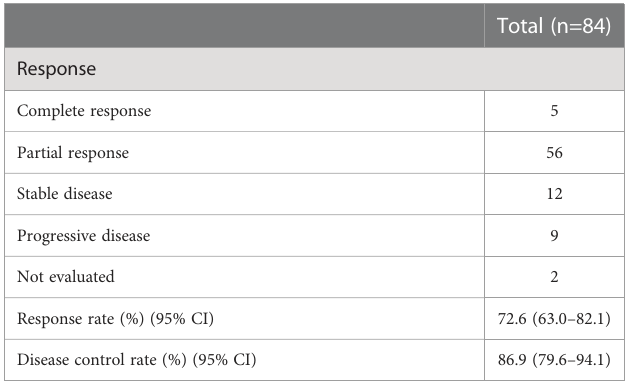
TABLE 2 Treatment